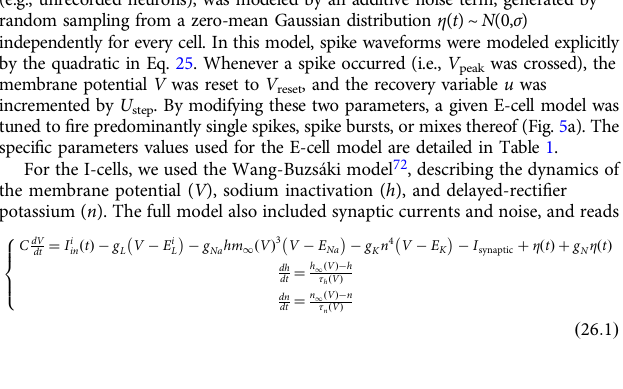
Table 1 Parameters used for modeling E-cells in the conductance-based networks.